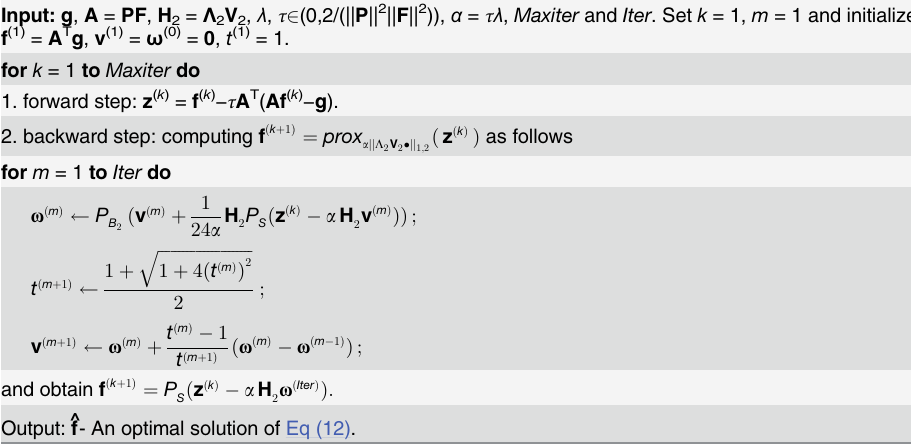
Table 1. The FBS algorithm for HDTV2-based image reconstruction. Input: g , A = PF , H 2 = Λ 2 V 2 , λ , τ 2 (0,2/(|| P || 2 || F || 2 )), α = τ λ , Maxiter and Iter . Set k = 1, m = 1 and initialize f (1) = A T g , v (1) = ω (0) = 0 , t (1) =